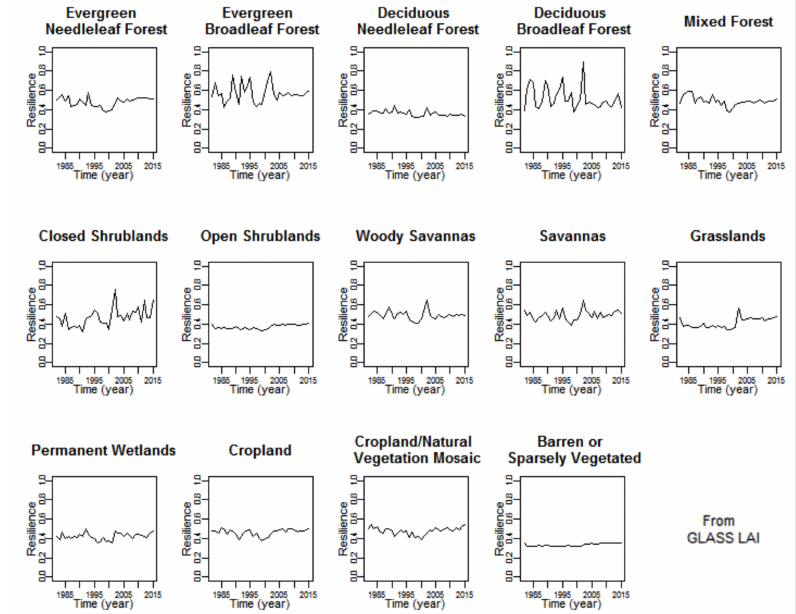
Figure 8. Annual variations of terrestrial resilience in di ff erent land-cover